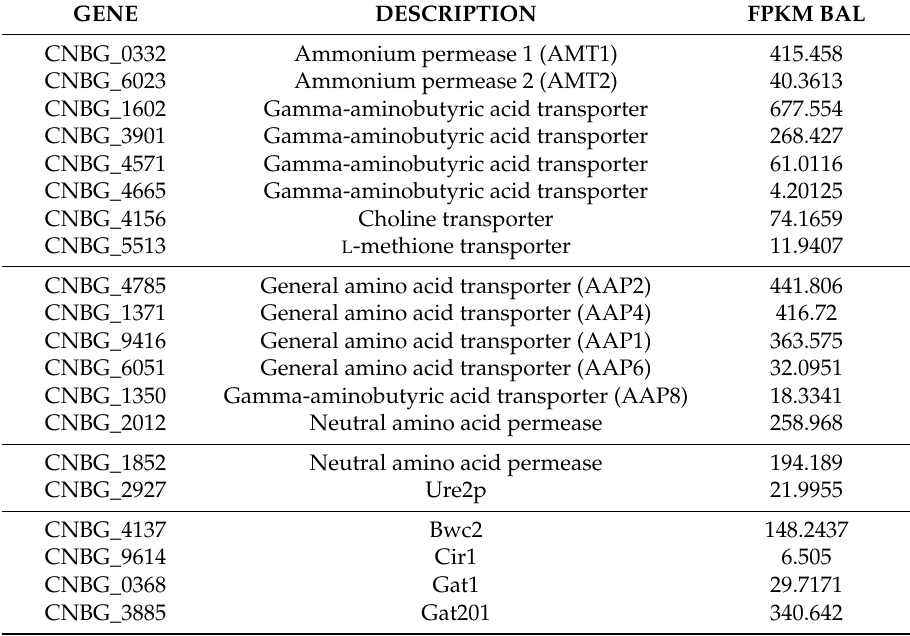
Table 2. FPKM values of ammonium permeases, amino acid transporters, and GATA transcription factors. GENE DESCRIPTION FPKM